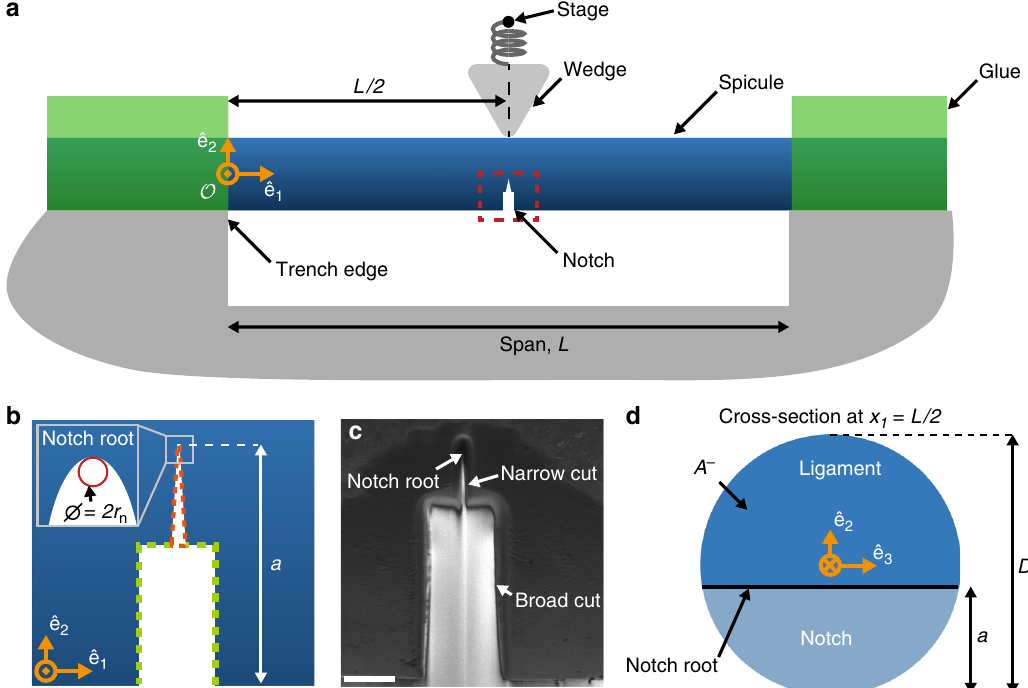
Fig. 4 Notched spicule specimen geometry. a A schematic of the test con fi guration. The stage is denoted by a black dot. b A magni fi ed view of the region shown in the red rectangle in a showing the notch geometry. The broad cut that was made using a high accelerating current is marked in green and the narrow cut that was made using the low accelerating current is marked in orange. c A scanning electron micrograph of the notch cut in a representative Ea . spicule. Scale bar is 2.5 μ m. d A schematic of the spicule's cross-section at x 1 = L /2 after notching. The notch root is straight and parallel to ^ e 3 . The notch length is a . The remaining ligament has a cross sectional area A − We cut a notch through part of the spicule ’ s cross-section representation of the spicule ’ s cross-section at x 1 = L ∕ 2 in which located mid way across the trench (i.e., at x 1 = L ∕ 2) using a the notched region is shown in light blue and the remaining focused ion beam (FIB) (see Fig. 4a, b and Section Spicule ligament is shown in dark blue. We refer to the apex or tip of the notching procedure). A representative micrograph of a notched notch as the notch root. The notch root is a straight line segment , see Fig. 4d). After cutting the notch, we spicule is shown in Fig. 4c. Figure 4d depicts a schematic that is parallel to ^ e 3